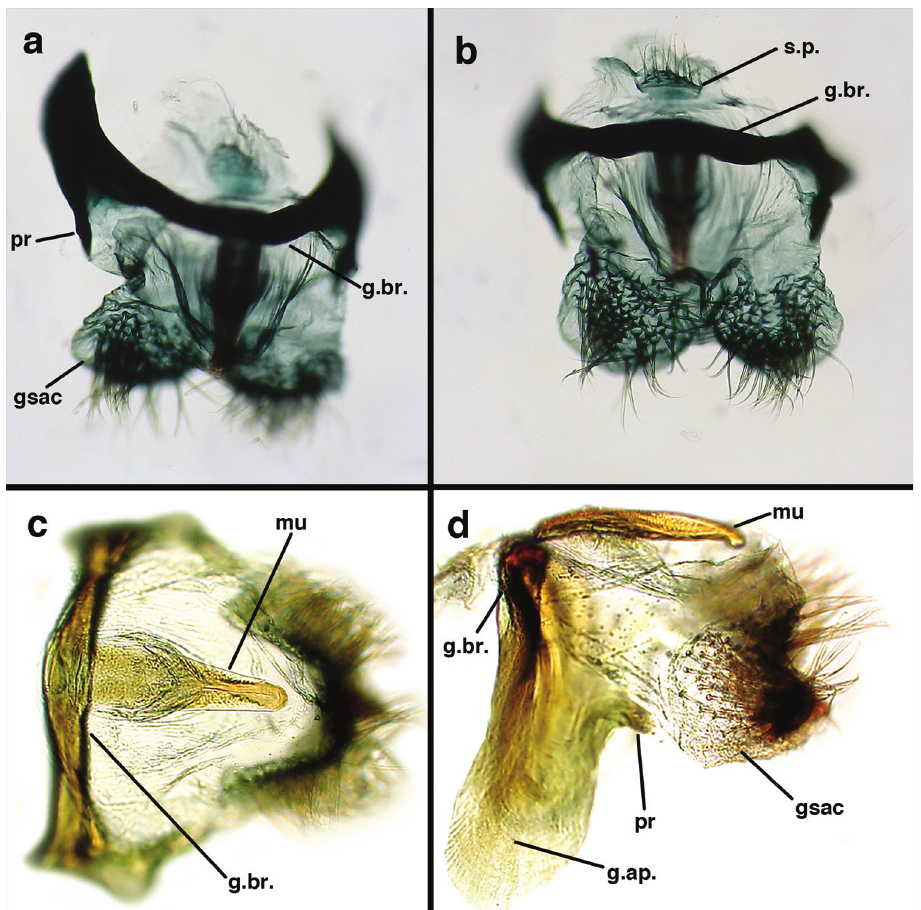
Figure 20. Ungla bolivari -like species: Male genitalia, ( a ) gonarcus, dorsal ( b ) gonarcus, frontodorsal ( c ) gonarcus and mediuncus, dorsal ( d ) gonarcus, lateral. g.ap. gonarcal apodeme g.br. gonarcal bridge gsac gonosaccus mu mediuncus pr unarticulated process on frontal margin of gonarcal apodeme s.p. se- tose subanal plate (all: Venezuela, Boconó, MIZA; images, FS). Male: Abdomen yellowish green. Tergites (T) and sternites (S) densely covered with both elongate, thin and short, thickened setae. Spiracles small. T9+ect cone- shaped, with posteroventral corner acute; dorsal apodeme lightly sclerotized, located on the lower margin of T9+ect; callus cerci ovate with ca. 38 trichobotria. S8+9 fused, in lateral view: tall anteriorly, mesal section tapering abruptly, with distal one third ca. 2.8 times longer than tall, slightly projected beyond apex of T9+ect; ventral apodeme sclerotized, extending along dorsal margin of basal section of S8+9, not reaching apex. Gonarcal bridge narrow, arched; lateral apodemes broad with digitiform projection; mediuncus densely covered with microtrichiae from medial area to apex; gonosaccus with elongate gonosetae on robust chalazae in two lateral